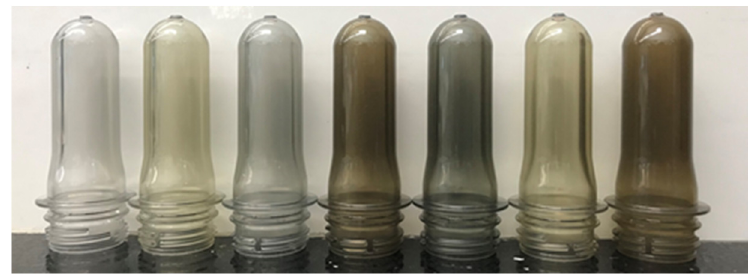
Figure 14. PCR preform color variation (image courtesy of Amcor).